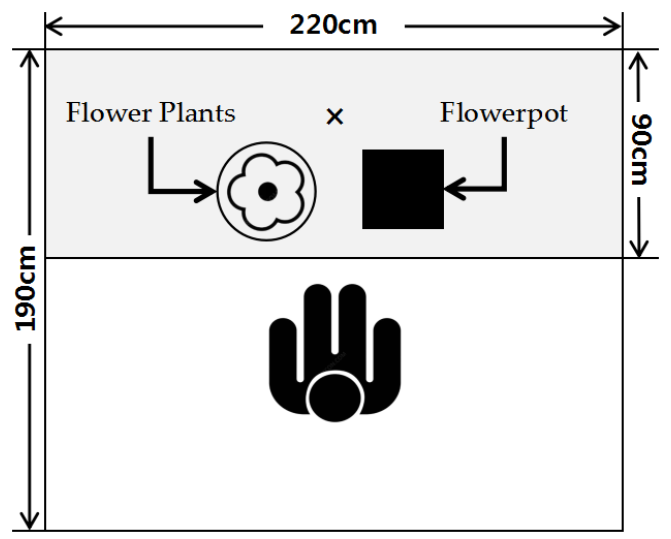
Figure 1. Experimental space layout.